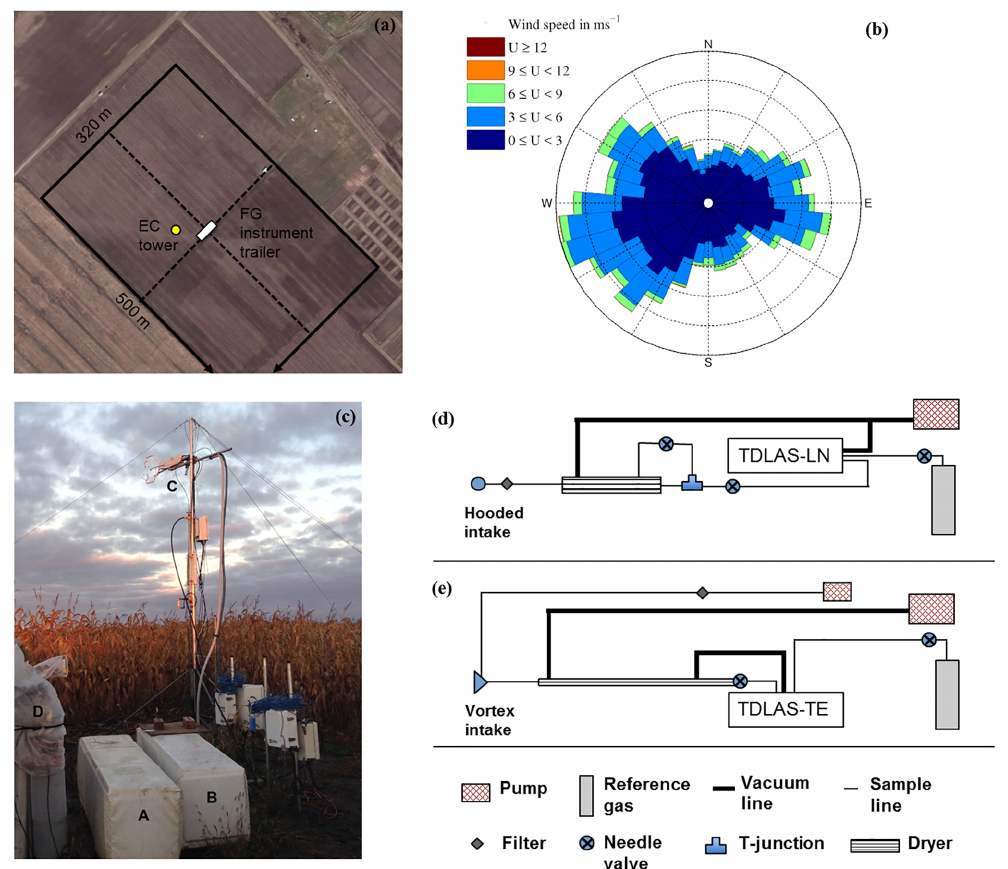
Figure 1. Descriptions of the field site and eddy-covariance instrumentation. (a) Layout of the field site. Dashed lines indicate the borders of the field treatments used in the larger four-plot flux gradient (FG) study. Instrumentation for that study was housed in the indicated instrumentation trailer located in the centre of the field. Solid lines outline the entire field. (b) Wind rose of the wind speeds and direction observed during the field study. (c) Configuration of the analyzers at the EC tower; A is TDLAS-LN, B is TDLAS-TE, C is EC155, and D is reference gases for the N 2 O analyzers. (d) Schematic of TDLAS-LN sampling system with inline filter and multi-tube dryer. (e) Schematic of TDLAS-TE sampling system with vortex intake and single-tube